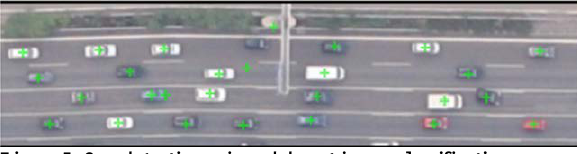
Figure 5: Car detection using adaboost image classification